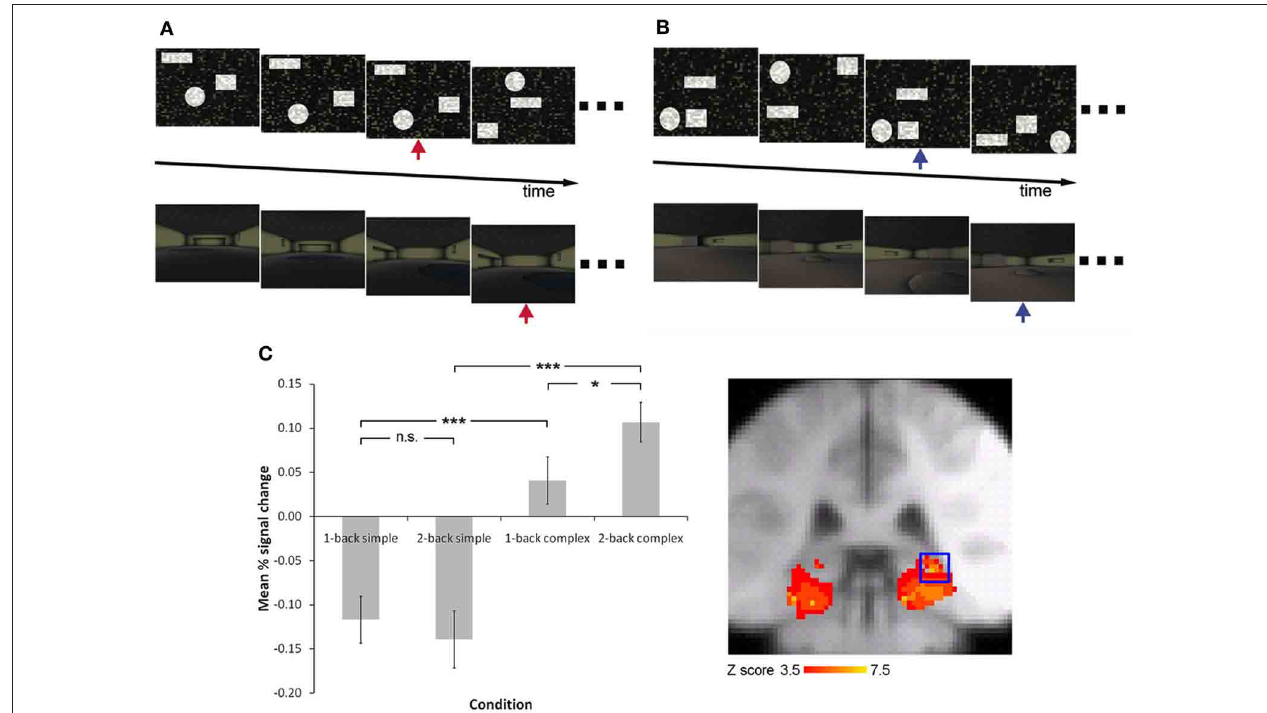
rooms (red arrow indicates one-back repetition target, blue arrow indicates two-back repetition target). The pattern of activity observed in the right posterior hippocampus is illustrated in (C) (activity rendered on the MNI152 template at p < 0 . 05 family wise error corrected for multiple comparisons with a small volume correction for the medial temporal